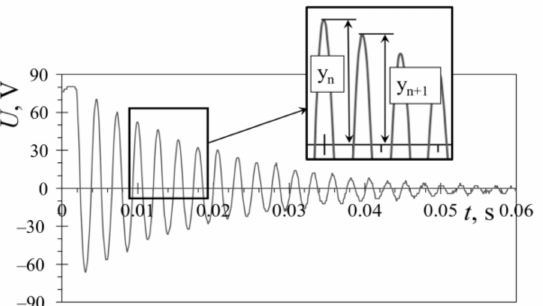
Figure 12. Typical mechanical response obtained by plucking the PEH’s free end.